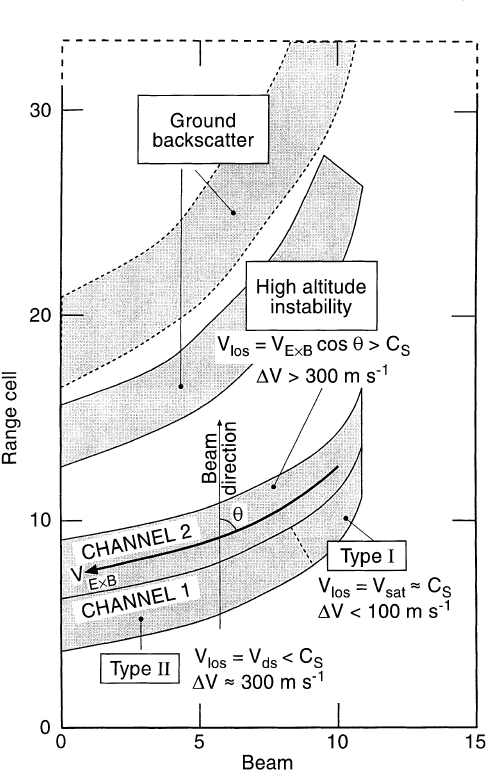
Fig. 3. A schematic diagram illustrating the typical locations of the channel 1 and 2 backscatter regions in the CUTLASS Iceland radar field of view, observed in the eastward electrojet region. Also indicated are the locations of ground backscatter regions associated with the ionospheric scatter; the ground backscatter at further ranges ( dotted outline ) is sometimes not observed. The instability mechanisms and line-of-sight velocities associated with the channel 1 and 2 backscatter are discussed in the text